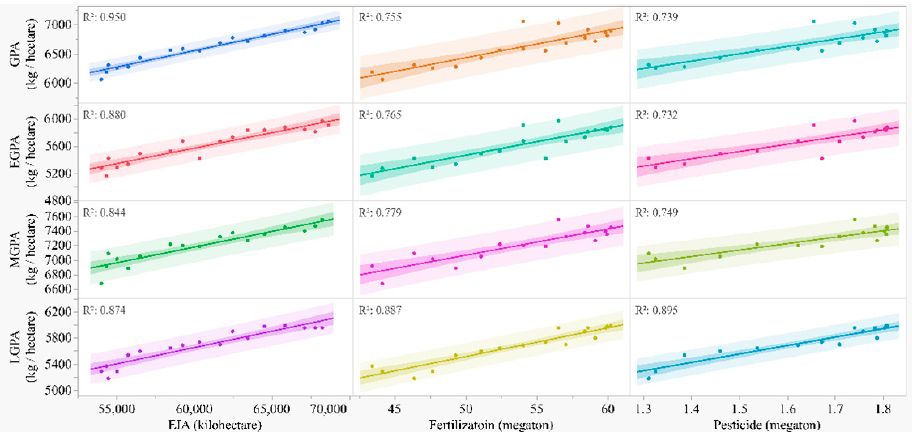
Figure 5. Grain yield per unit area (GPA) in total, early (EGPA), middle (MGPA), and late rice (LGPA) in the recent 20 years against effective irrigation area (EIA), fertilization, and pesticide used by the whole agricultural production in the country. Predictions and R-squares are from the polynomial regression model.